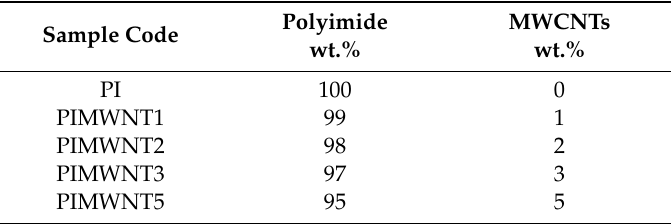
Table 1. Material concentration, including multi-wall carbon nanotubes (MWCNTs), per prepared coded